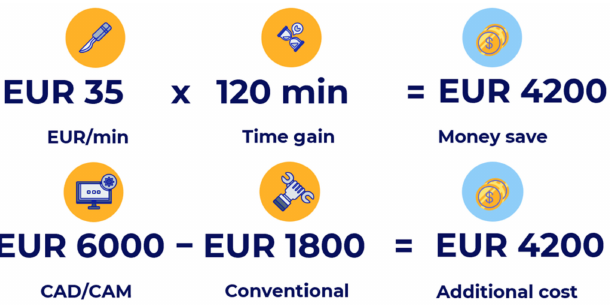
Figure 2. Cost savings. Cost comparison of pre-curved plates and virtual planning, taking into account the cost savings from the OR time